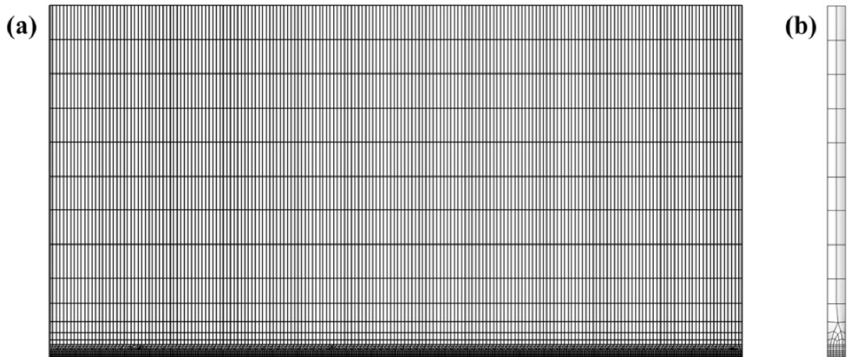
Figure 1. Finite element model: ( a ) top view and ( b ) side view.